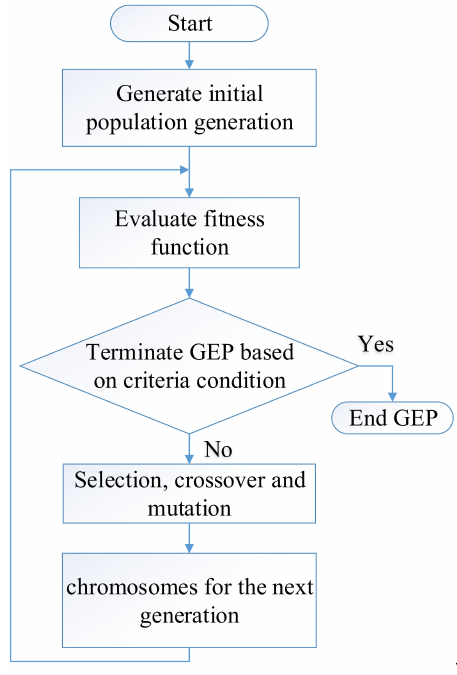
Figure 1. General Flowchart for GEP algorithm.